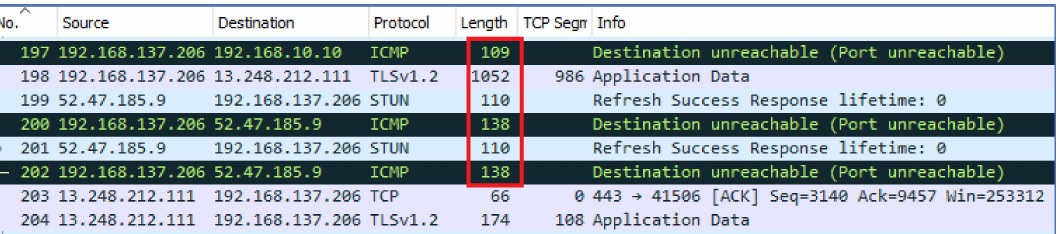
Figure 11. The traffic pattern of established calls from User A to User B.